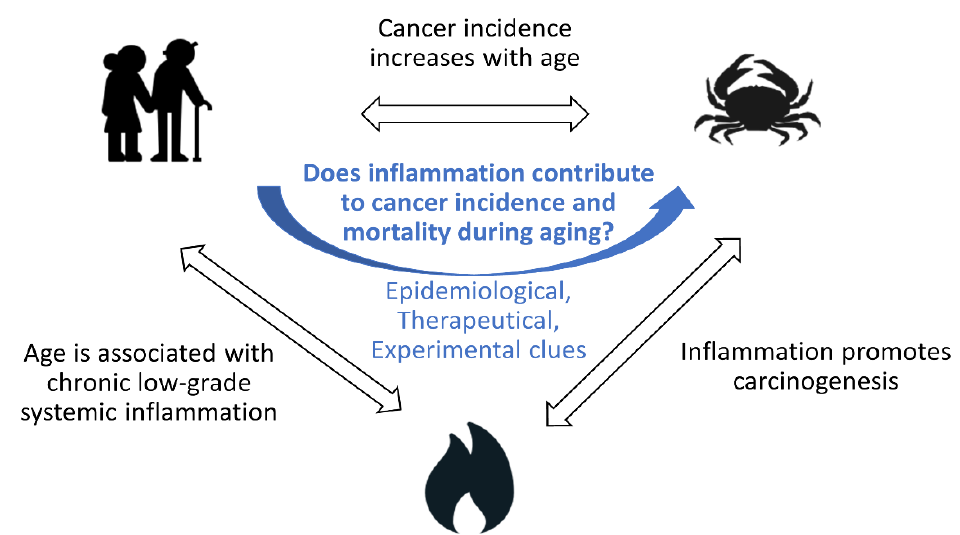
Figure 1. Does age-associated chronic low-grade inflammation contribute to the increase in cancer incidence and/or mortality observed during aging?